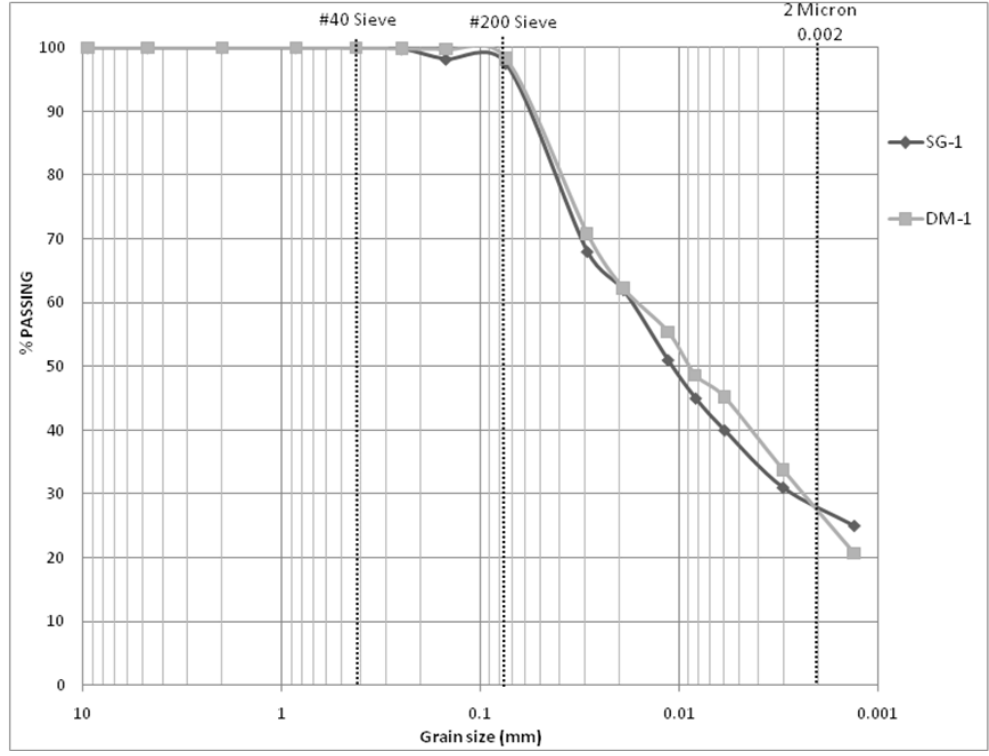
Figure 6. Comparison of grain size distributions: Manually processed drilled vs . grinder processed stockpiled samples (DM-1 &